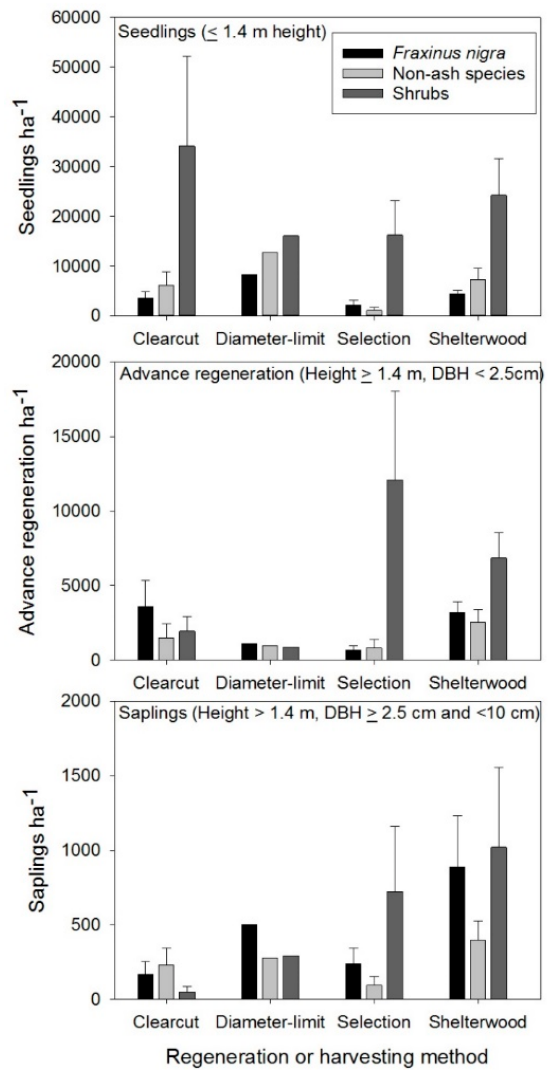
Figure 6 . Natural regeneration response to different regeneration methods and diameter-limit cutting as part of the Wisconsin Department of Natural Resources silviculture trials in black ash lowland forests in north-central Wisconsin. Data in figures are based on field measurements of these trials in 2015 and values represent means ± 1 standard error. Sites were harvested between 2003 and 2013 and all exist on Black Ash–Balsam Fir–Red Maple/Sensitive Fern (FnAbArOn) habitat types. Sample sizes for the different regeneration methods and harvesting approaches are: strip shelterwood ( n = 6), clearcut ( n = 4), diameter limit ( n = 1), and single-tree selection ( n = 4). Non-ash species include Acer rubrum , Betula alleghaniensis , Abies balsamea , Ulmus americana , Betula papyrifera Marsh., and Thuja occidentalis . Shrub species are predominantly Alnus incana , Salix spp ., and Corylus cornuta .